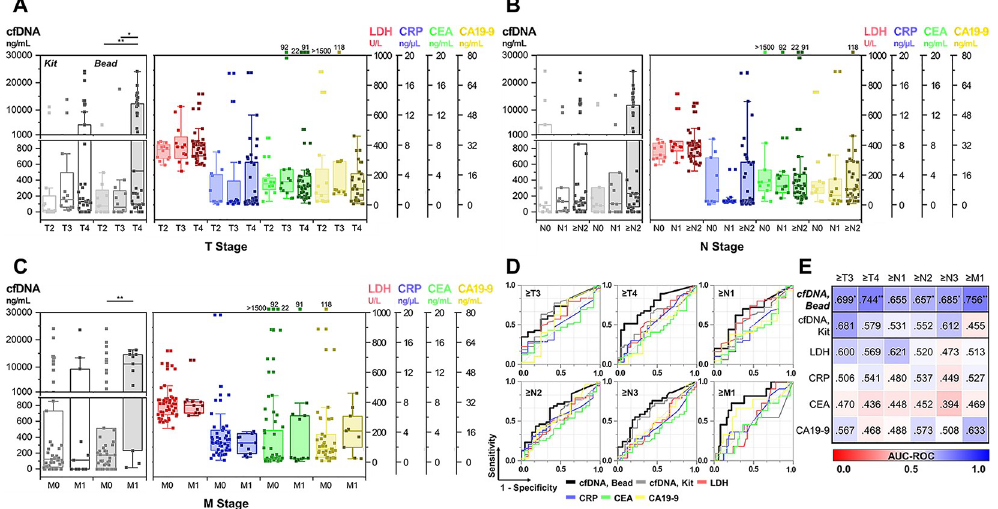
(b) N, and (c) M stage. (d) The ROC curve analysis demonstrating clinical capability of the new cfDNA separation system in discriminating cancer patients depending on the TNM